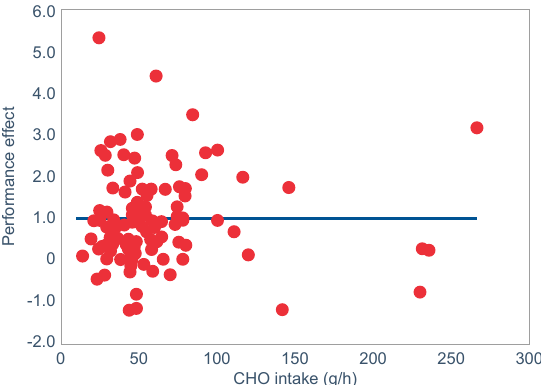
Figure 29. The absence of any relationship between the amount of carbohydrate ingested per hour during exercise and any measured performance benefit. Adapted with permission from ref. [139]. Copy-right 2010 Springer Nature.